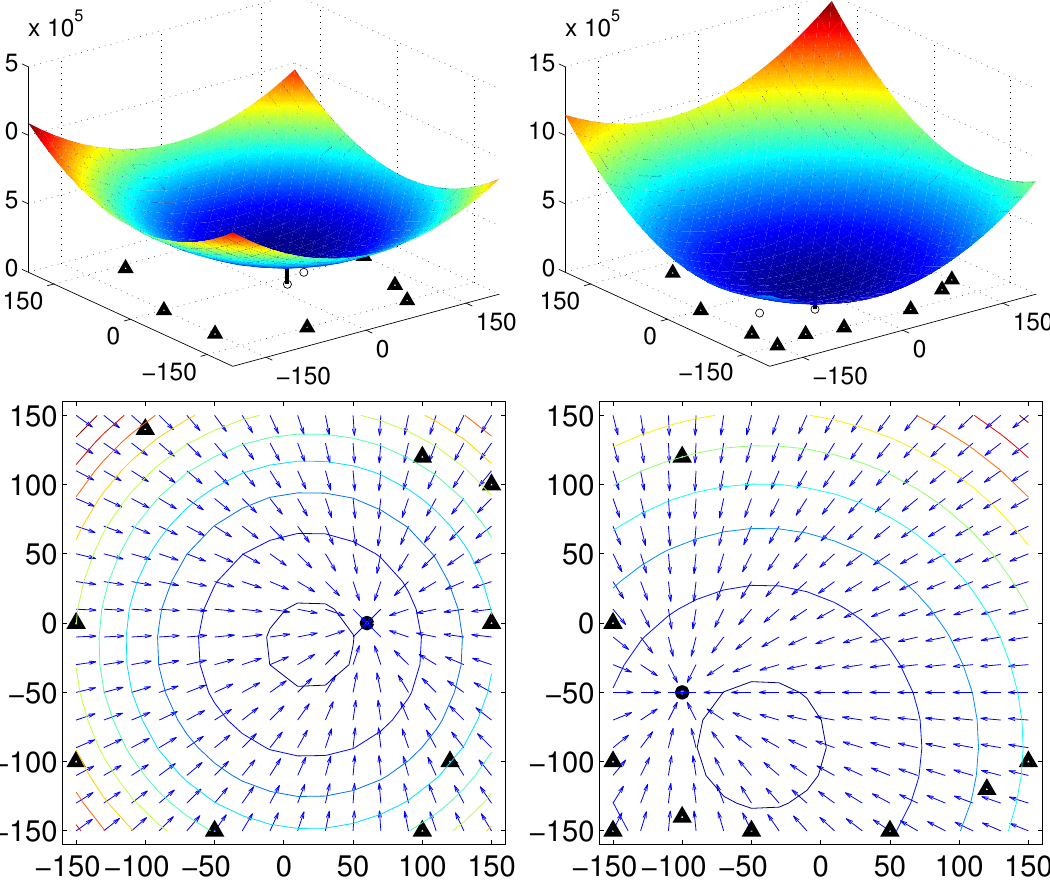
Figure 6. Test with two different simulation environments; the first row shows the moment potential, and the second row shows vector maps including the homing vector on the contour plot (triangles: landmark positions, black dot: home